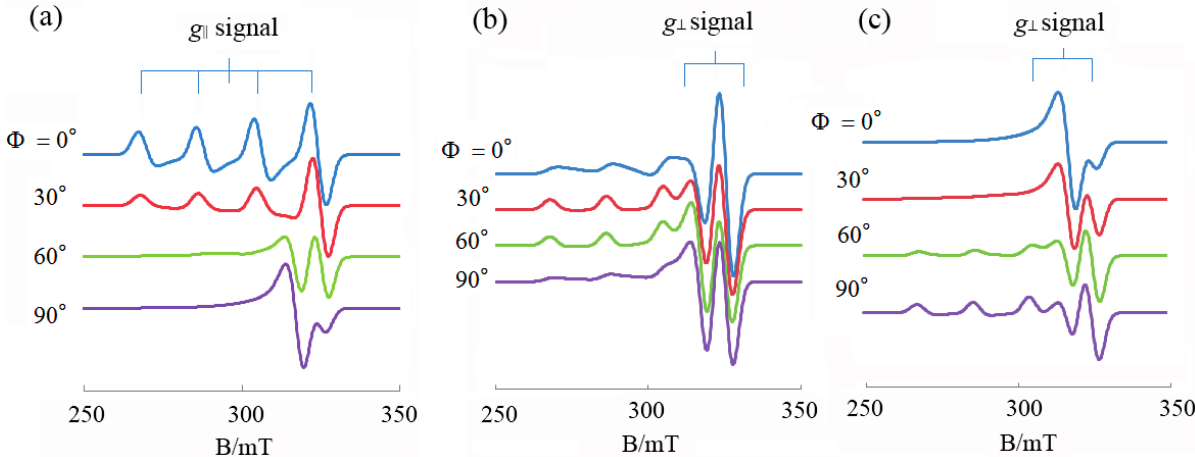
Figure 2. DNA fiber EPR spectra calculated for a planar Cu(II) complex. ( a ) θ 0 = 0°; ( b ) θ 0 = 45°; ( c ) θ 0 = 90°; Δθ = 20°; g || = 2.20, g ⊥ = 2.05; A || =180.0 G, (cid:1827)